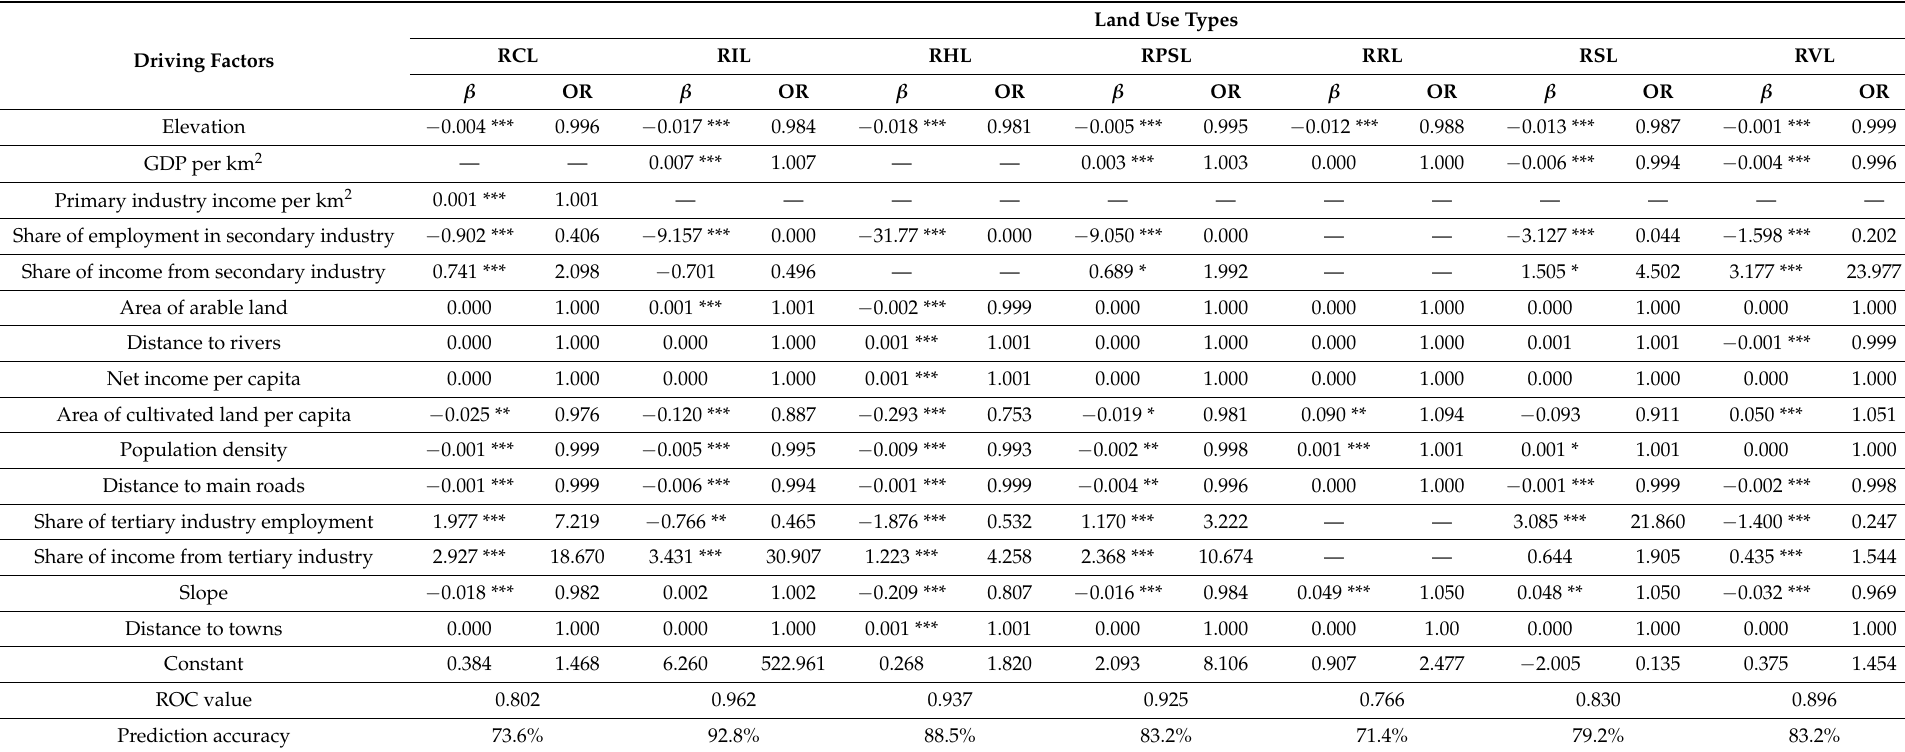
Table 1. Analyzing the driving factors of the RSILUS